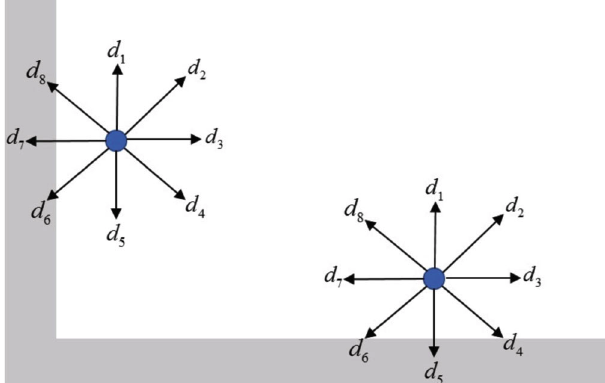
Figure 2: Possible movement directions (blue arrows) when individuals are near wall